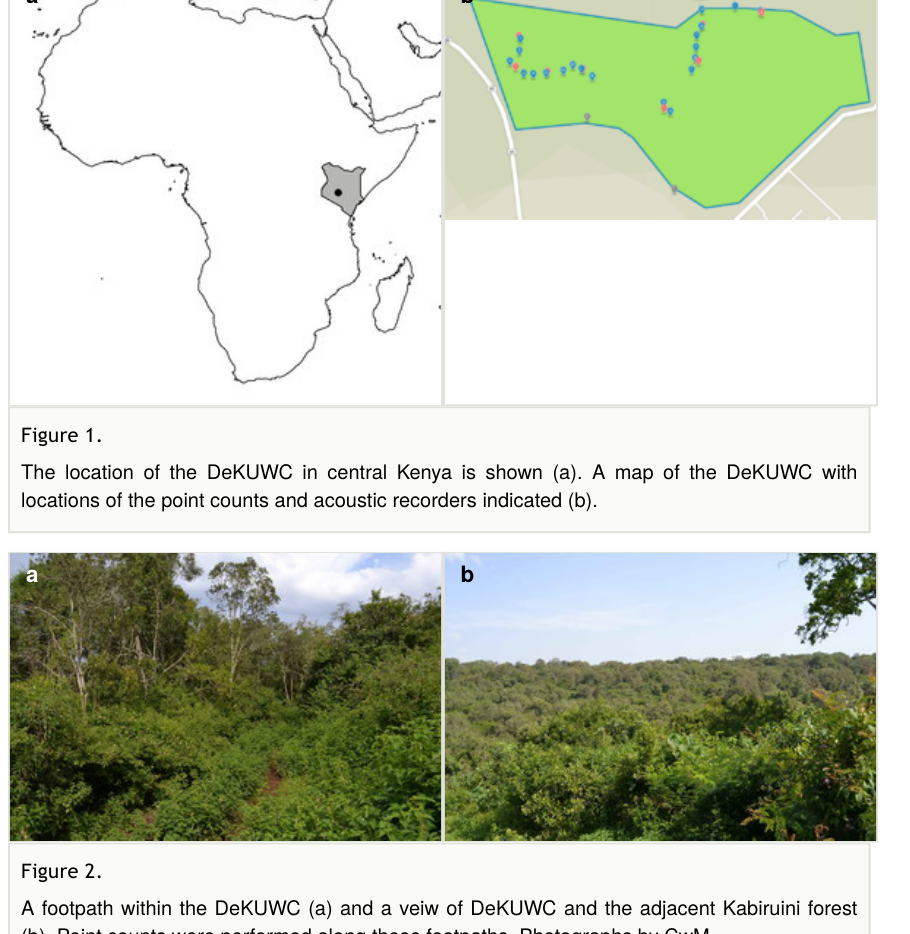
A footpath within the DeKUWC (a) and a veiw of DeKUWC and the adjacent Kabiruini forest (b). Point counts were performed along these footpaths. Photographs by